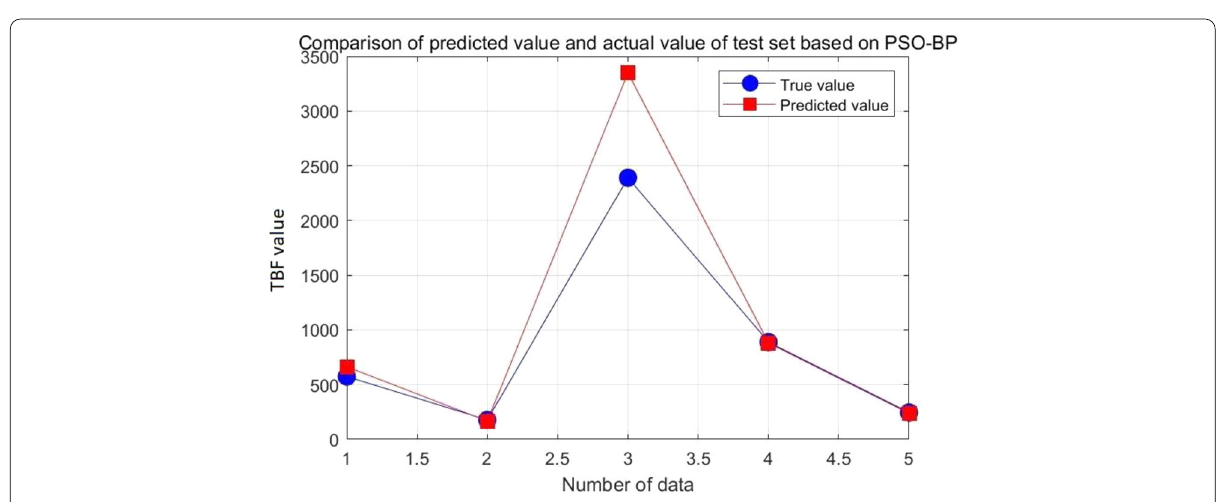
Figure 6 Comparison of the predicted value of the test sample with the true value